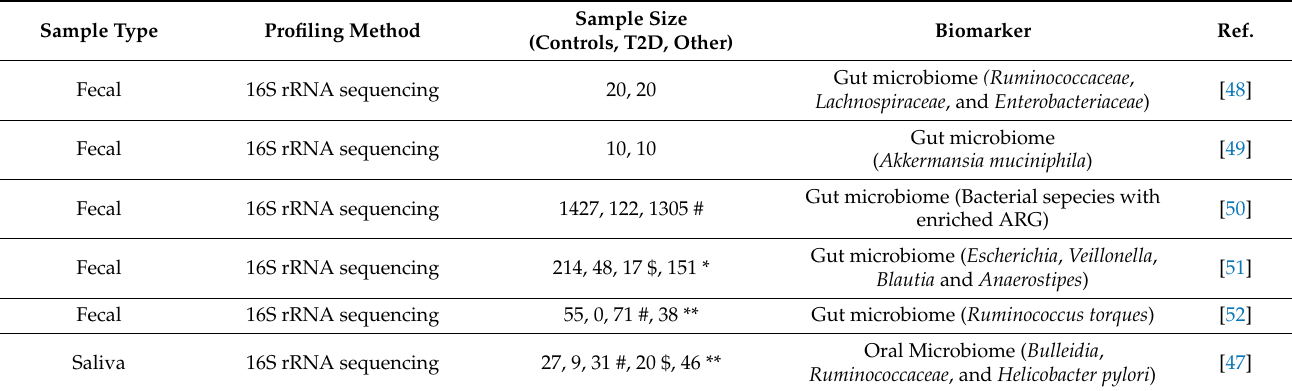
Table 4. Genomics and metagenomics biomarkers from saliva and fecal samples for